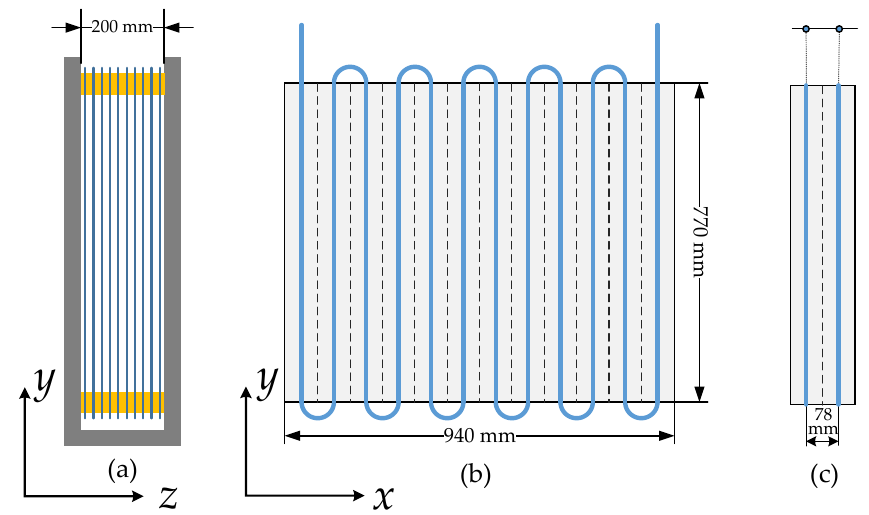
Figure 3. Schematic of ice storage container ( a ), coil-plate unit ( b ), and tube-sheet units ( c ).